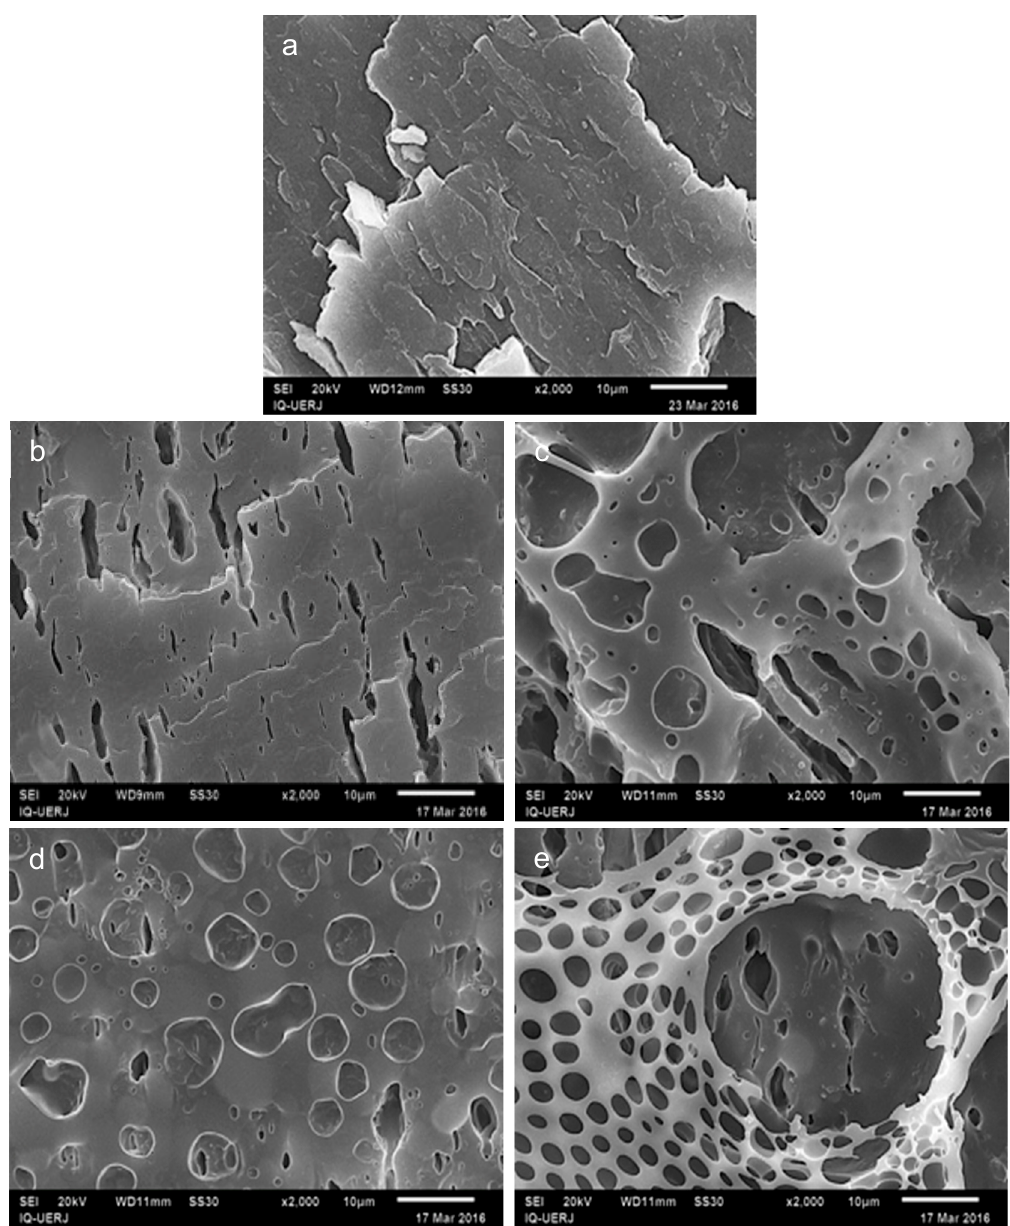
Figure 4. SEM micrographs for PP/HIPS 4:1 without CNSL, before extraction ( a ), and after extraction ( b – e ): without CNSL ( b ), with 2.5 phr CNSL ( c ), and with 5 phr CNSL at different regions of the sample ( d , e ). Amplification 2000× (10 μ m scale).